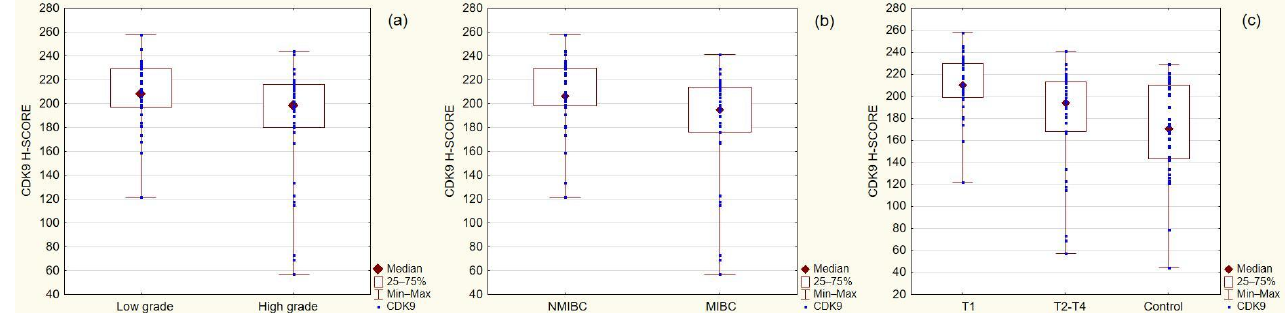
Figure 2. CDK9 expression depending on: ( a ) tumor grade ( p = 0.04); ( b ) tumor invasiveness ( p = 0.0075); ( c ) tumor stage ( p = 0.0001). NMIBC—non-muscle-invasive bladder cancer; MIBC—muscle-invasive bladder cancer.